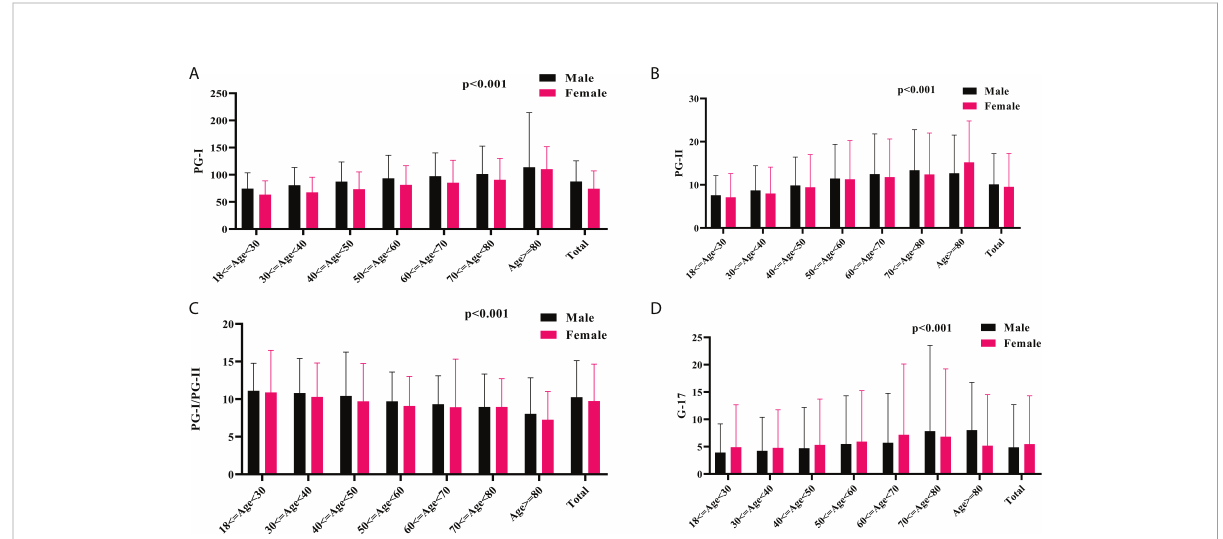
FIGURE 2 The association of serum PGs and G-17 with age and gender. The mean serum levels of PGI (A) , PGII (B) , PGI/PGII ratio (C) , and G-17 (D) among different gender and age groups. PG, pepsinogen; G-17,